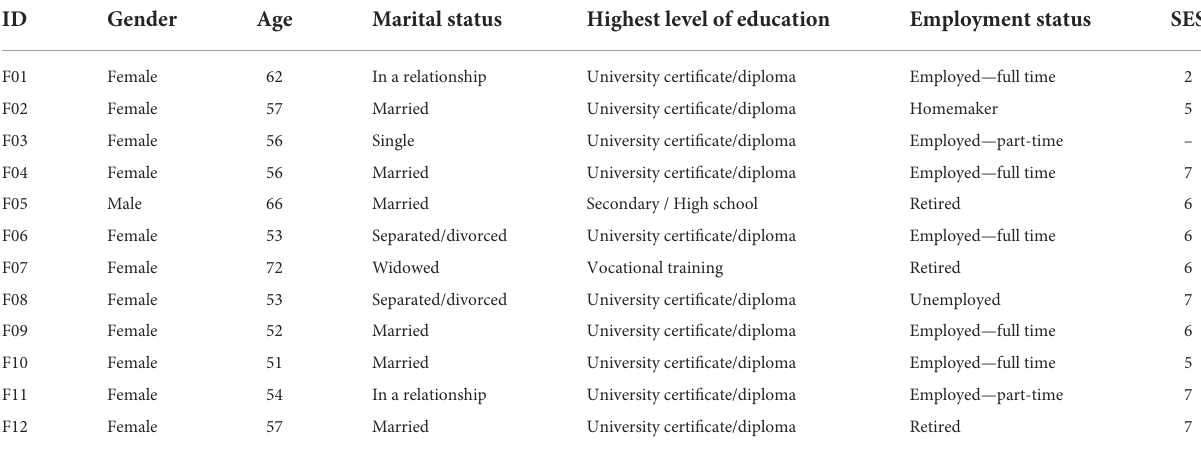
TABLE 1 Participant characteristics for the intrafamilial sample.